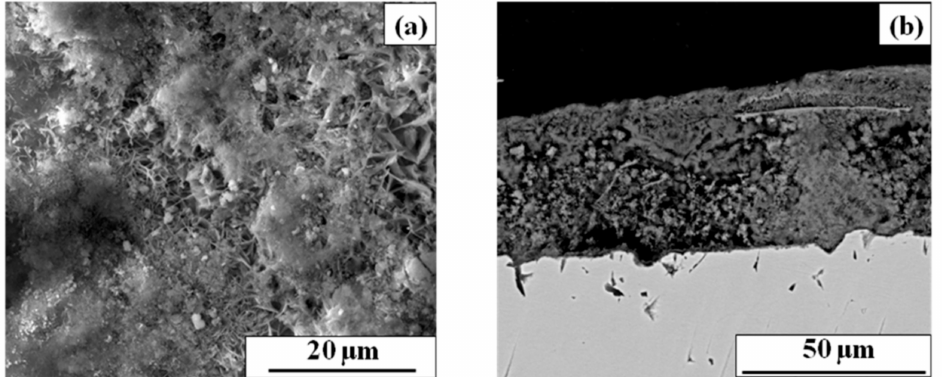
Figure 3. The surface ( a ) and cross-sectional ( b ) morphology of the rust